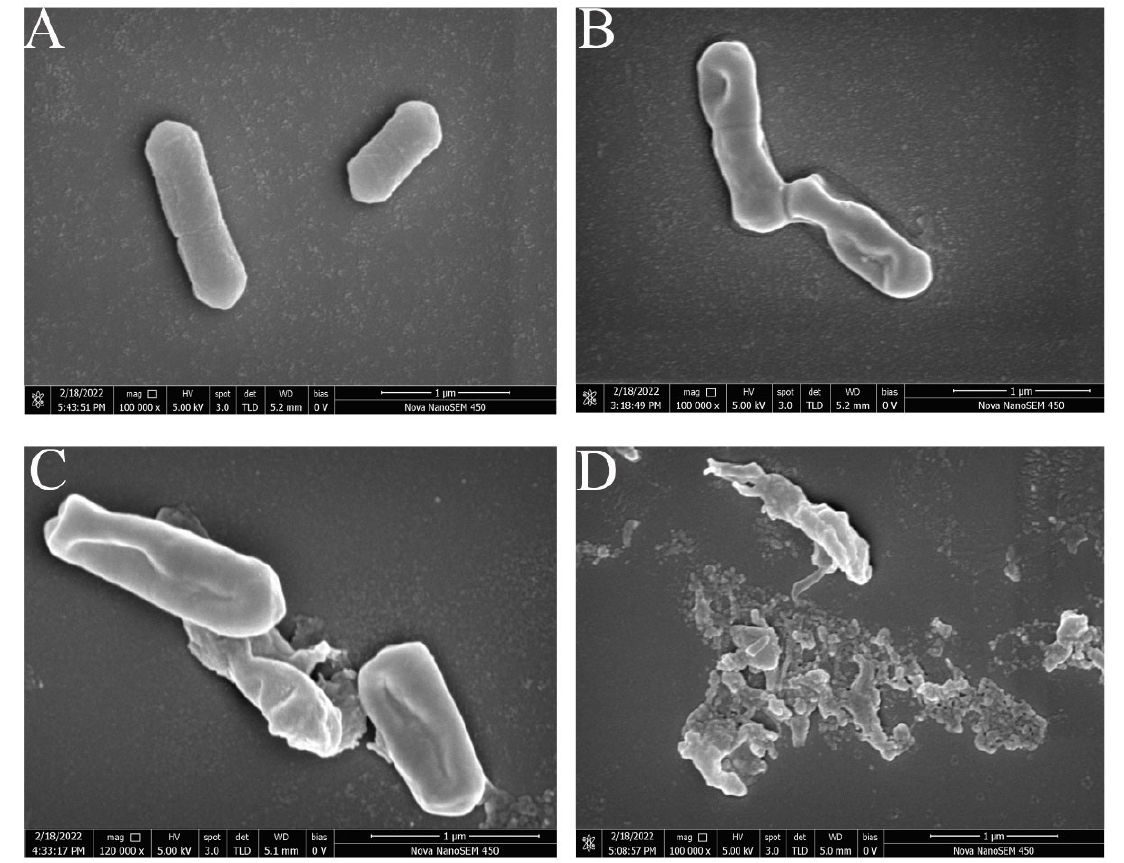
Figure 5. Scanning electron micrographs of L. monocytogenes untreated for 4 h ( A ) and treated with juglone at 50 µ g/mL ( B ), 100 µ g/mL ( C ), and 200 µ g/mL ( D ) for 4 h. Note: bar scale is 1 µ m, magnification 100,000×.